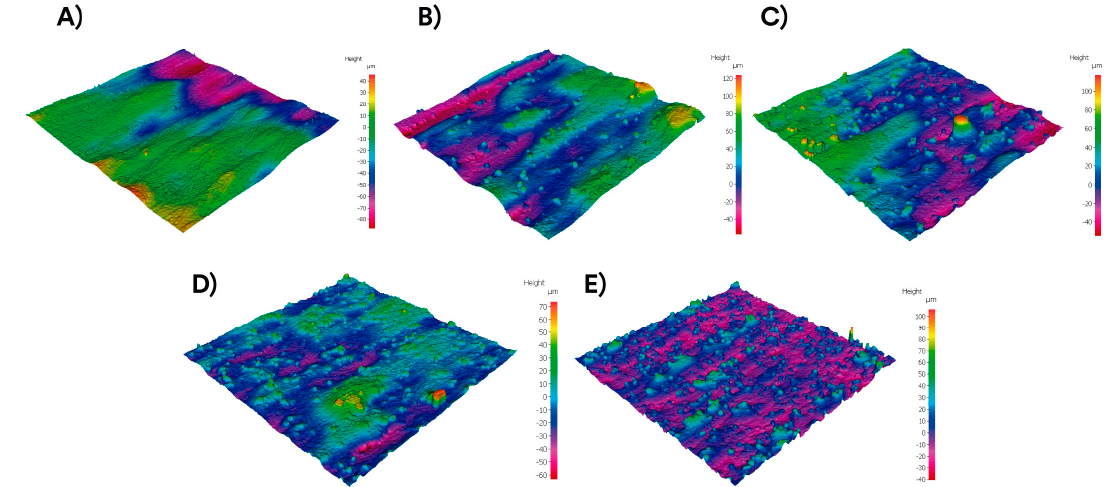
Figure 6. Top surface topographies at different sloping angle ( θ ) with meander scanning path. ( A ) 90°, ( B ) 70°, ( C ) 60°, ( D ) 45°, and ( E ) 0°.